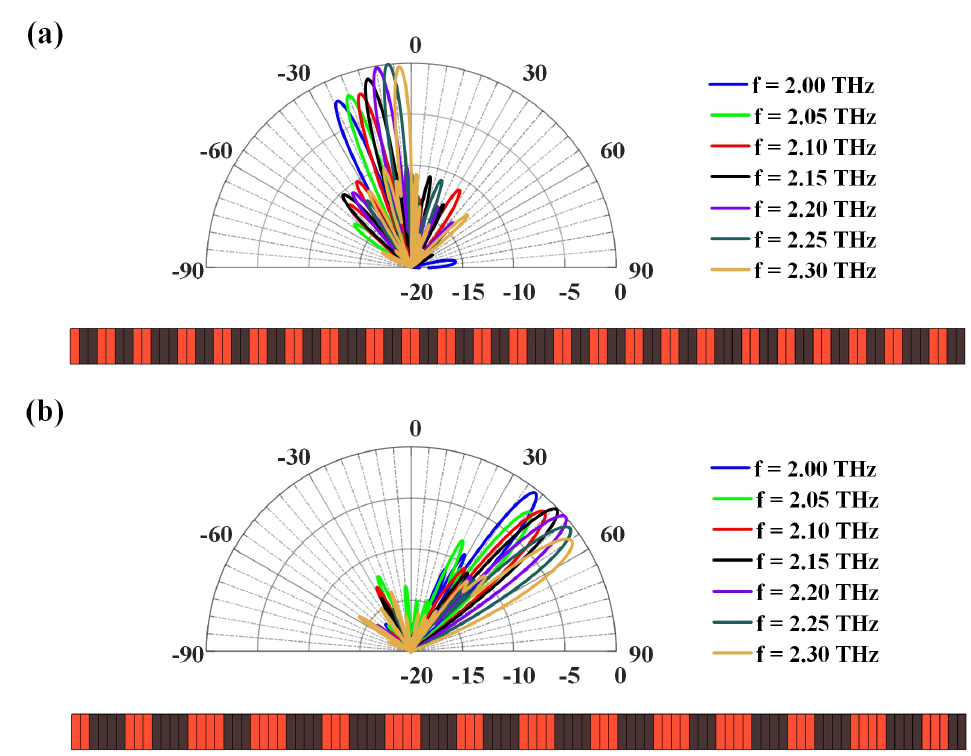
Figure 5. Frequency scanning of the graphene-biased terahertz coding meta-surface from 2 THz to 2.3 THz. Scanning beams of the meta-slot array at a certain coding state with the original radiation of θ 0 = − 10 ◦ ( a ) and θ 0 = 50 ◦ ( b